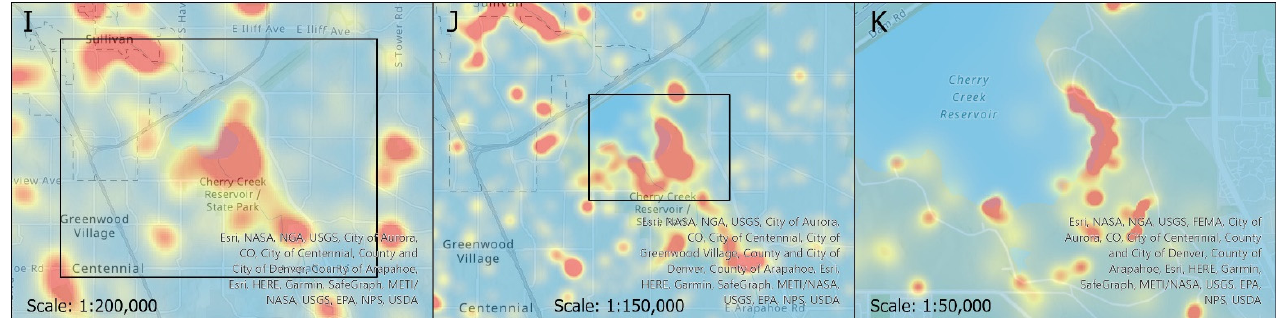
Figure 3. Observation hot-spots (2020) detected and rendered at micro-scales in a park in Denver. ( I – K ) corresponds to the increasingly large map scales at which hot-spots are detected and visual- ized.